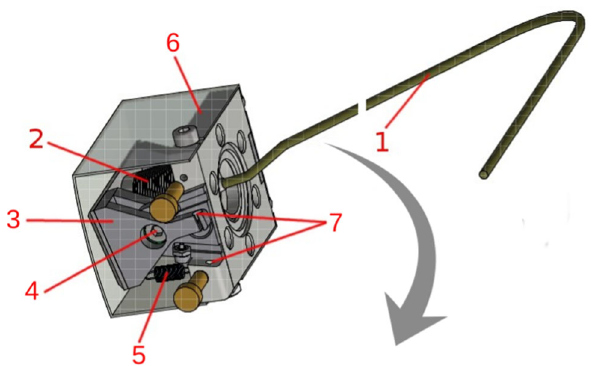
Fig. 6 Technical drawing of an electron catcher controller: (1) elec- tron catcher, (2) bellows, (3) hinge, (4) rotation axis, (5) spring, (6) photosensor housing, (7) pneumatic muscle cable slots. The grey arrow shows the direction of the catcher when moving inside the flux